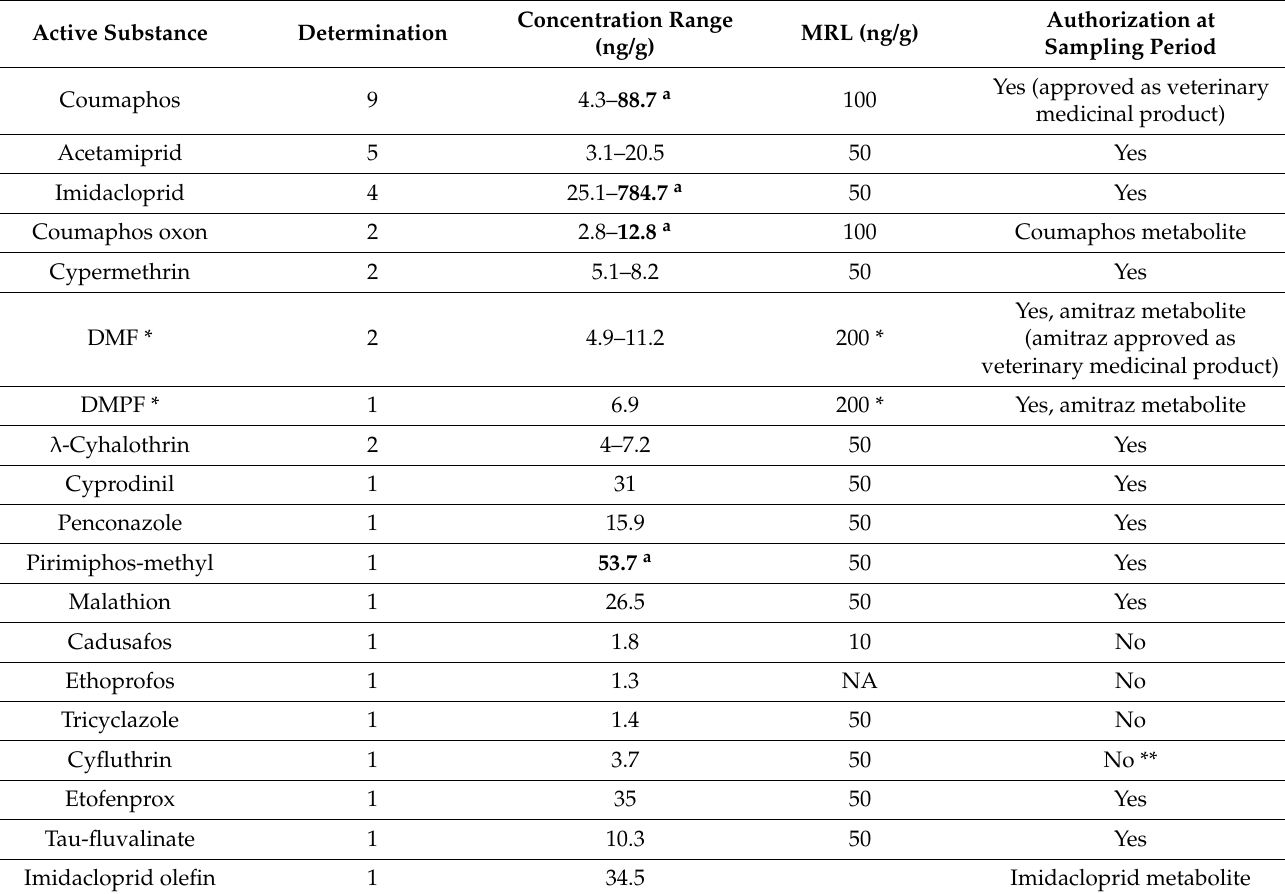
Table 1. Active substances, determinations, and concentration ranges in honey samples.